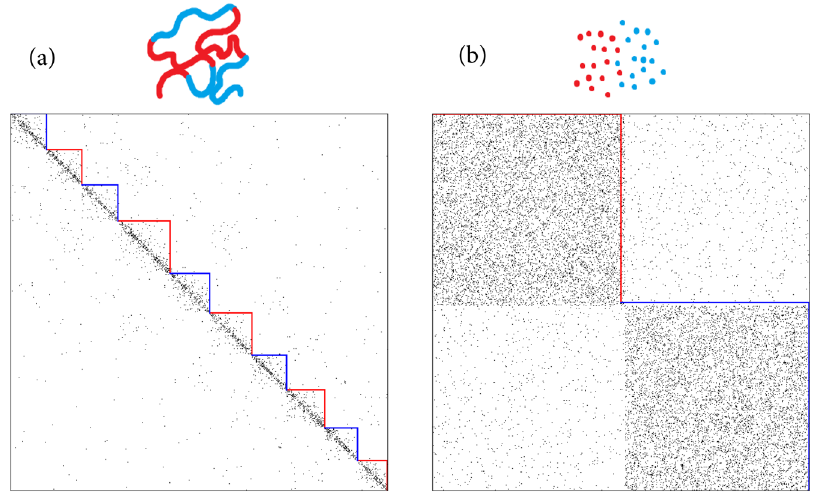
1000 with two clusters generated according to the ( a ) polymer Figure 1. Adjacency matrices of N = 1 , (cid:31) s 1, w out 0.1, P ( s ) 100 ) and ( b ) canonical stochastic block model stochastic block model ( w in − = = = = 0.1, w out 0.01, (cid:31) 500 ). Vertices in the graph are enumerated by the polymer coordinate ( a ) and first ( w in = = = all red, then all blue ones ( b